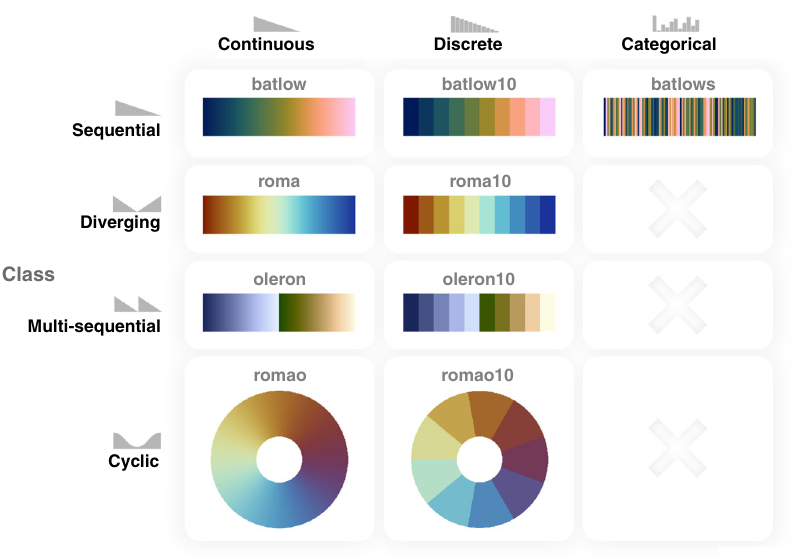
Fig. 5 Colour map classes and types. The various classes of colour maps ( sequential ; diverging ; multi-sequential ; cyclic ) and types ( continuous ; discrete ; categorical ). Only sequential colour maps can be faithfully applied to categorical types of